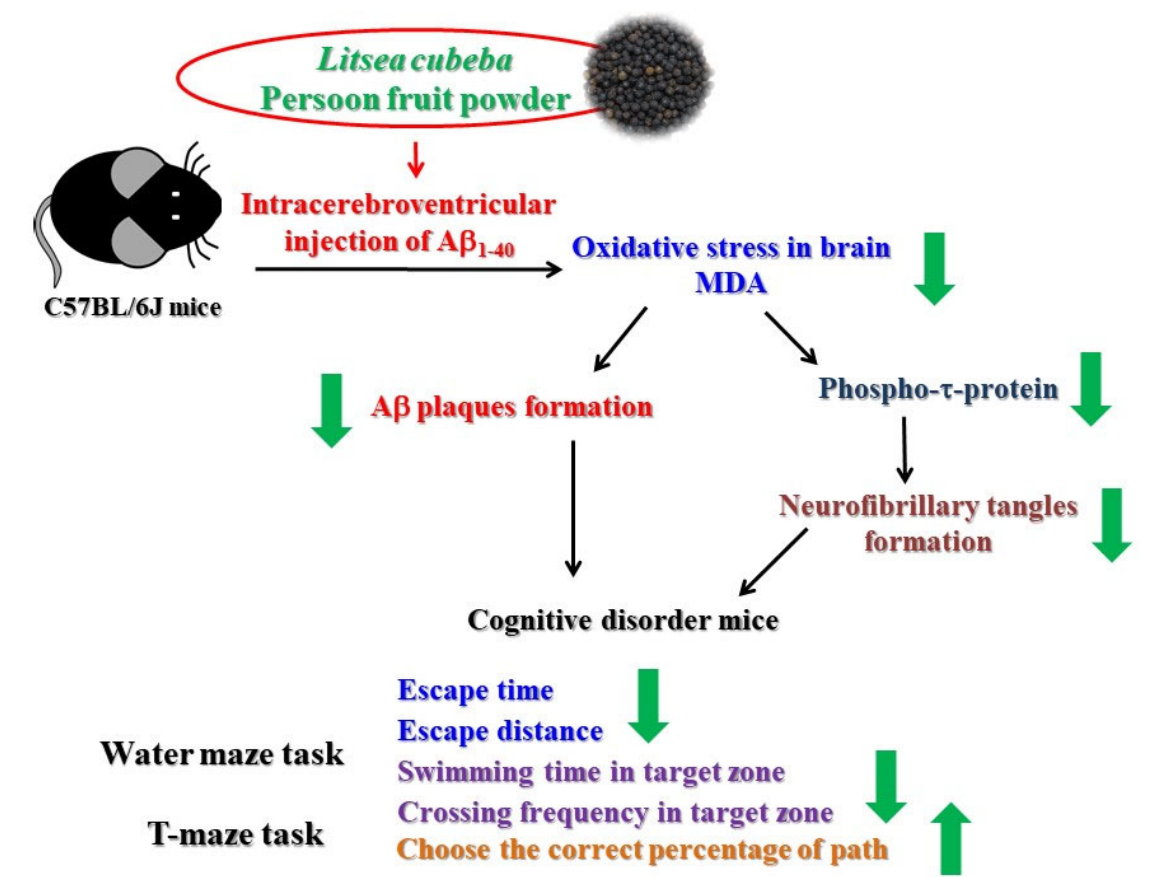
Figure 5. Hypothetical diagrams for roles of LCP fruit powder in A β -induced Alzheimer’s mice. LCP: Listea cubeba (Lour.) Persoon; A β : Amyloid β ; MDA: Malondialdehyde; p- τ -protein: Phosphorylated tau protein; NFT: Neurofibrillary tangle.